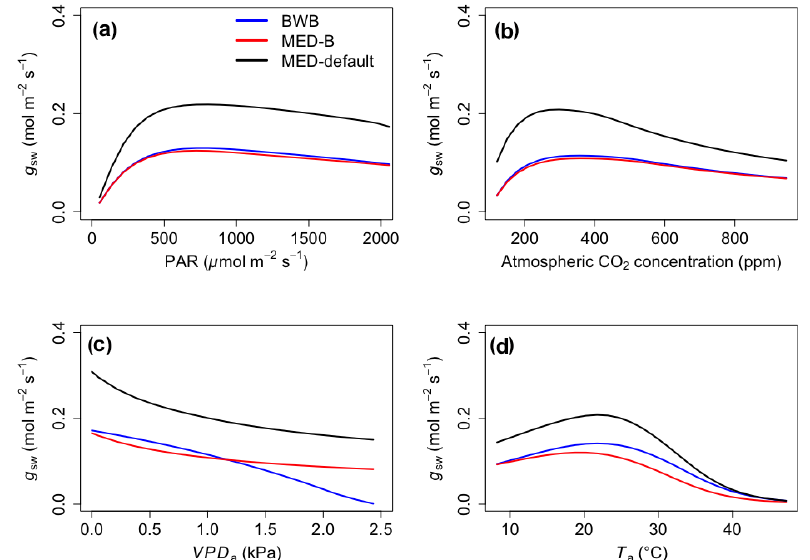
Figure 1. The responses of stomatal conductance ( g sw ) to scenarios with (a) radiation, (b) CO 2 , (c) VPD a , and (d) T a for the three model setups: BWB (blue), MED-B (red), and MED-default (black).